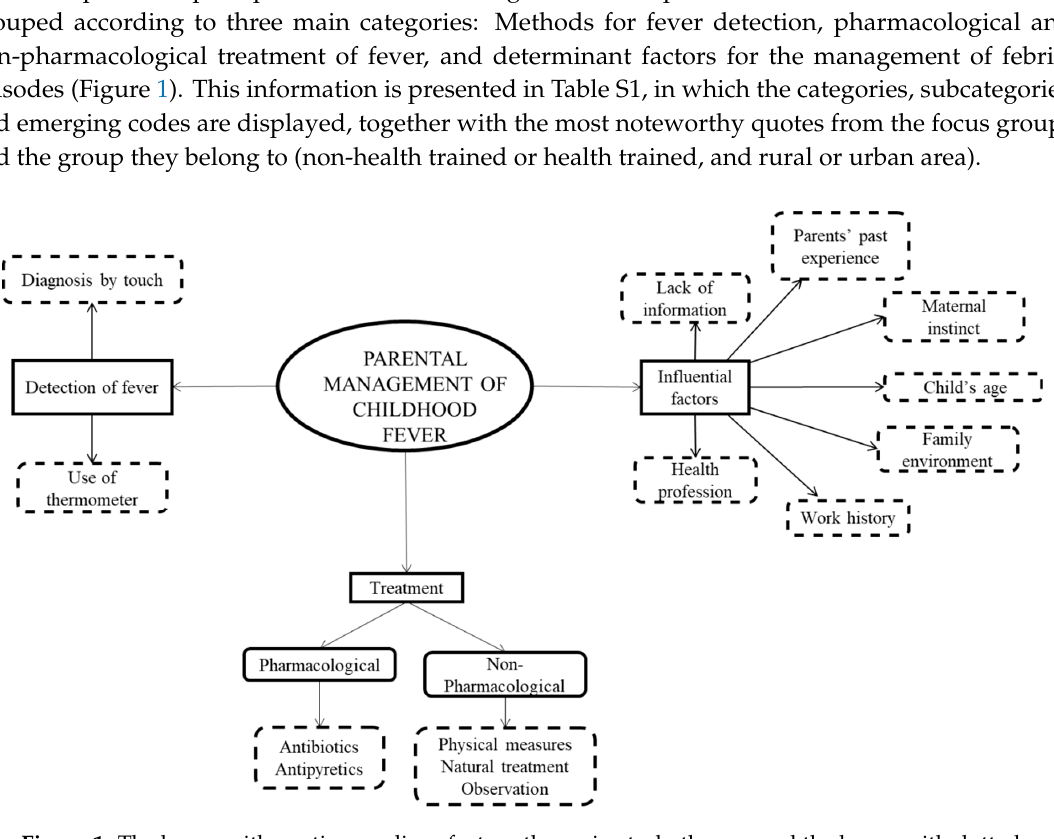
Figure 1. The boxes with continuous lines feature the main study themes and the boxes with dotted lines represent the categories.